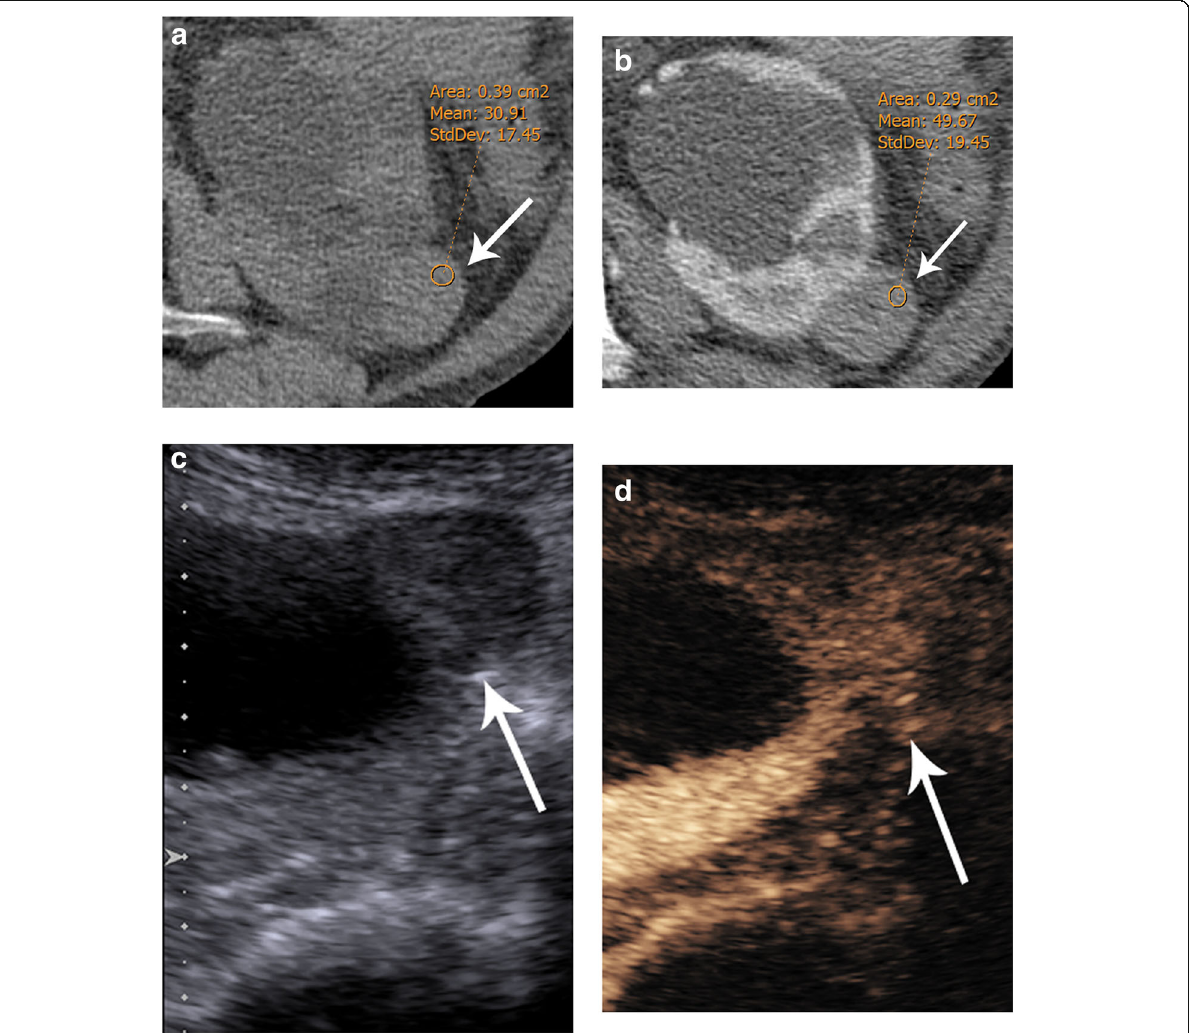
Fig. 5 Indeterminate renal mass by CT in an 82-year-old patient. a Axial unenhanced and ( b ) enhanced CT showing a renal mass with attenuation greater than 20 HU in unenhanced CT that enhances less than 20 HU after contrast administration, considered indeterminate by CT (arrows). c Unenhanced and ( d ) contrast-enhanced ultrasound (US) of the same lesion clearly depicting enhancement of this lesion consistent with a solid renal tumor (arrows), thereby allowing an indeterminate CT renal mass to be reliably classified as a solid